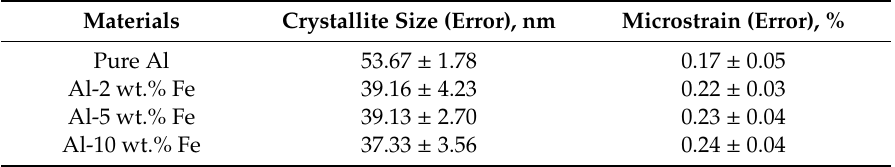
Table 1. Alloy crystallite size and microstrain.